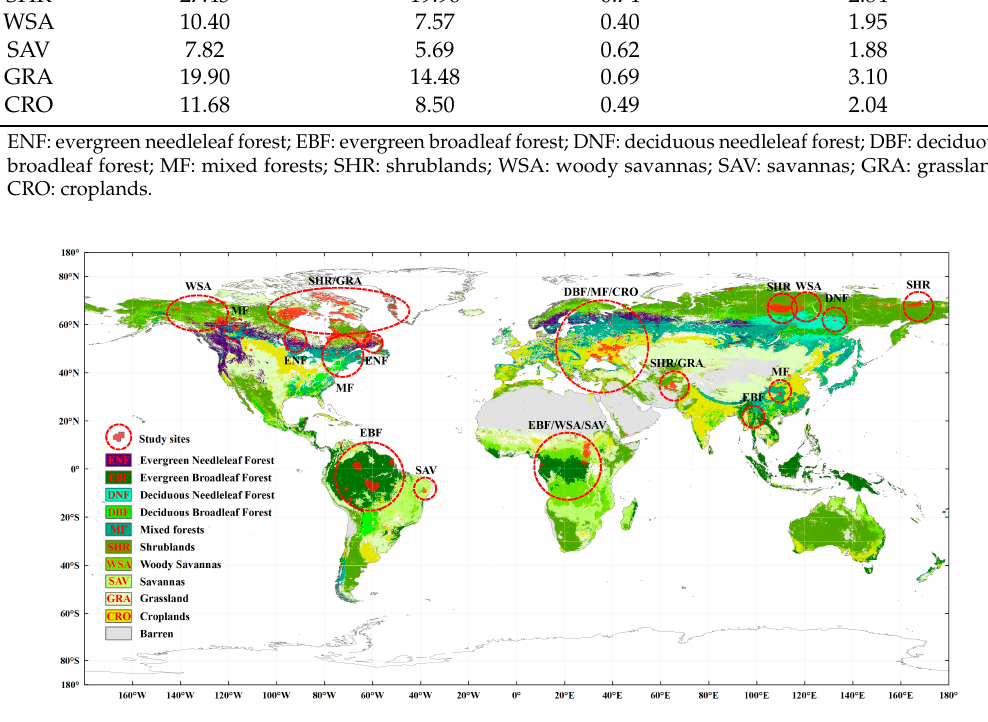
Figure 2. Study sites for the various vegetation biomes, all identified within the 90th percentile of the increment of MAT (+MAT). Table 1. Statistics of area, area percent, +MAT, and +MAT at the 90th percentile for various vegetation biomes at the global scale.